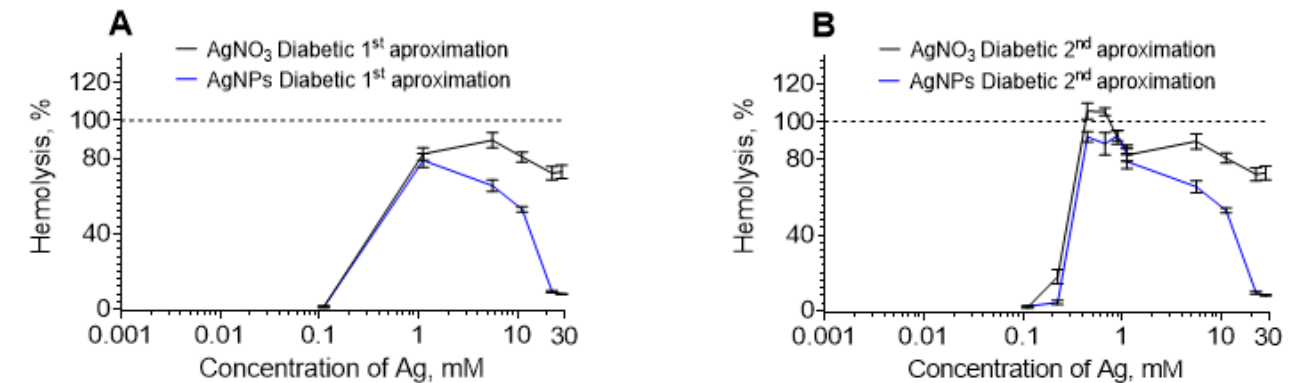
Figure 3. Hemolysis induced at pH 7.4 in DDE: ( A ) first approximation with two experimental points and ( B ) second approximation with six experimental points in the interval 0.1–1 mM. Hemol- ysis for AgNPs is depicted in blue lines and AgNO 3 in black lines.